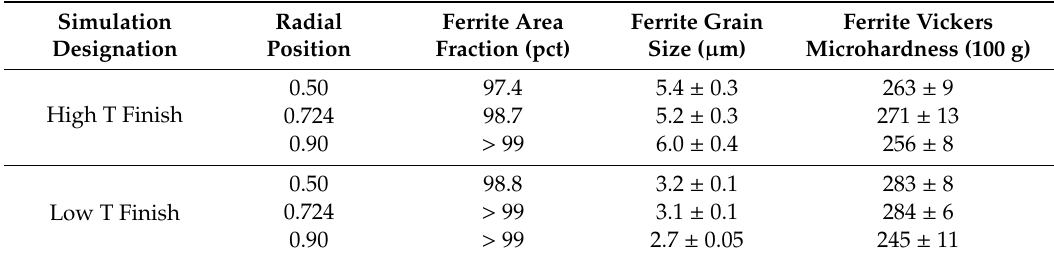
Table 4. Characteristics of Isothermally Transformed